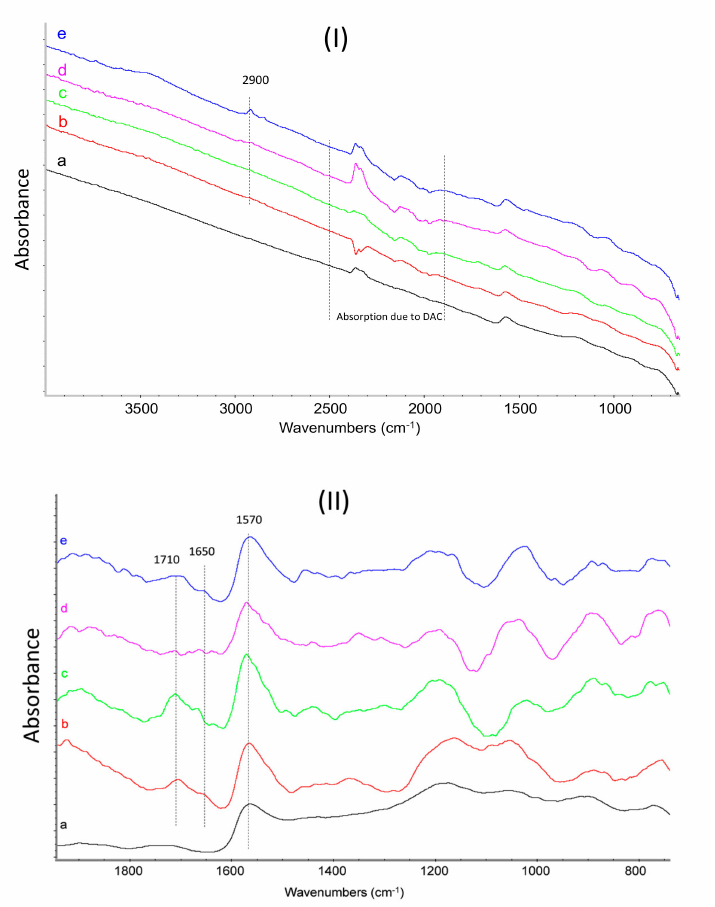
Figure 6. Fourier transform infrared spectroscopy (FT-IR) spectra of: ( a ) CNTs, ( b ) CNT-SP, ( c ) CNT-1,2,5-trimethyl-1 H -pyrrole (TMP), ( d ) CNT-2,5-dimethyl-1-(3-(triethoxysisyl)propyl)- 1 H -pyrrole (APTESP), and ( e ) CNT-1-dodecyl-2,5-dimethyl-1 H -pyrrole (DDcP). Panel ( I ): 700–3900 cm − 1 region; Panel ( II ): fingerprint region 700–1800 cm − 1 after baseline correction. Spectra are displayed with normalized intensity. Peaks discussed in the text and the absorption features due to the diamond anvil cell (DAC) accessory are labeled in the